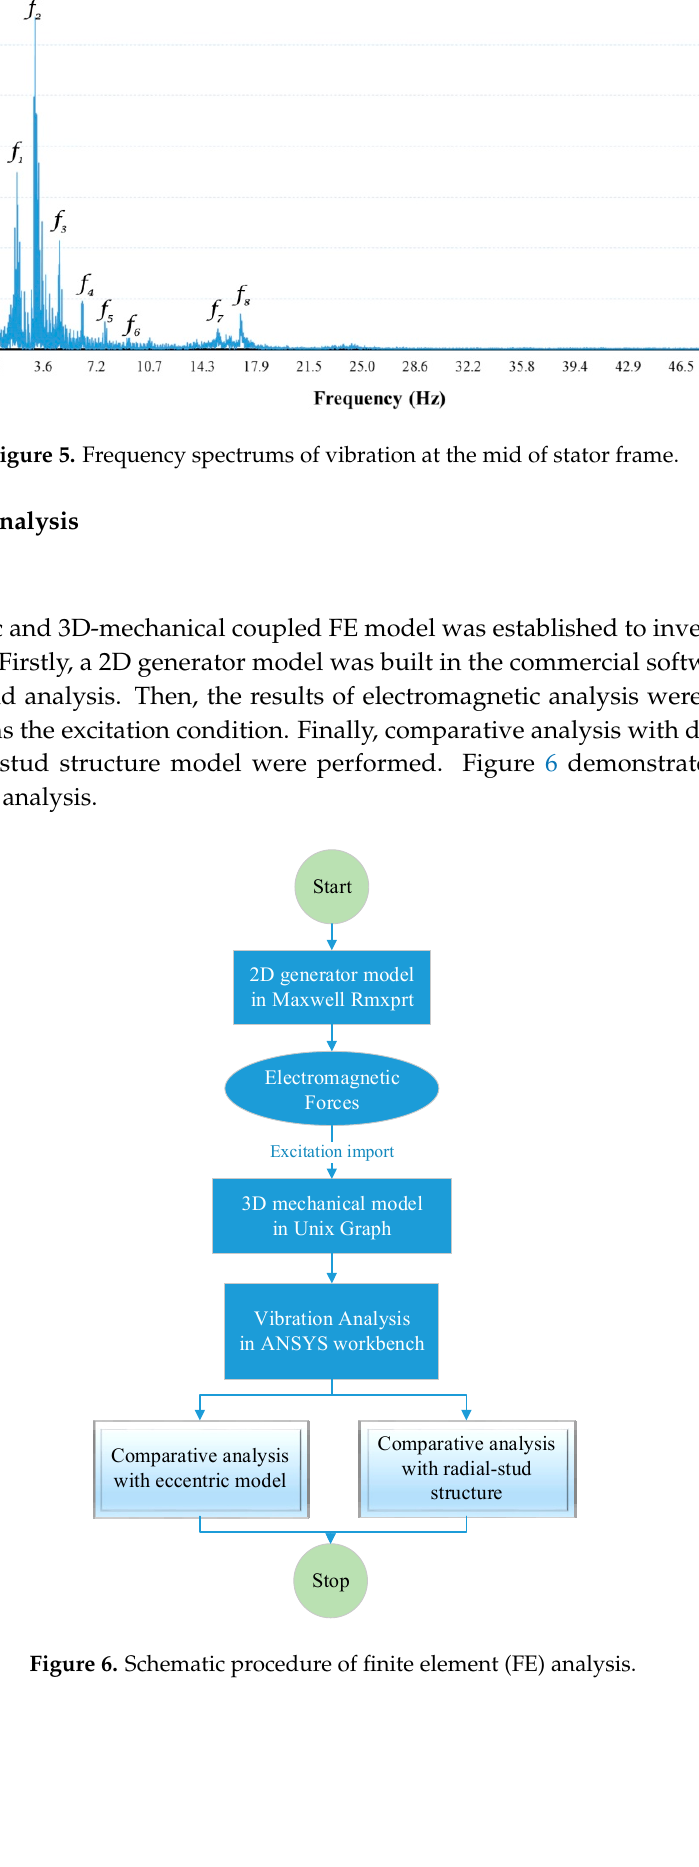
Figure 6. Schematic procedure of finite element (FE) analysis.